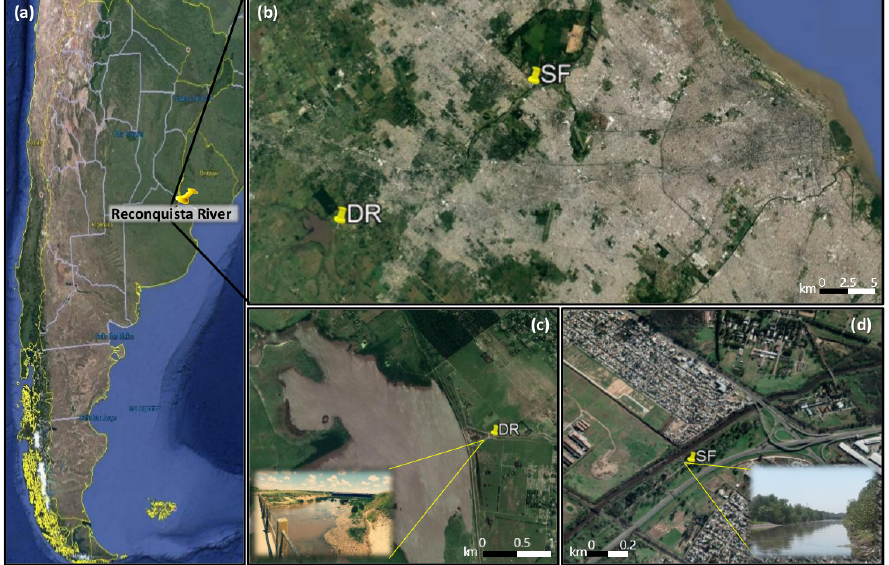
Figure 1. Satellite images of the peri urban Reconquista River location ( a ) and the two sampling sites ( b ): DR, Dique Ingeniero Carlos F. Roggero (34 ◦ 40 (cid:48) 51.4” S, 58 ◦ 51 (cid:48) 36.7” O) and SF, Parque San Francisco, William Morris, (34 ◦ 34 (cid:48) 42.3 (cid:48)(cid:48) S, 58 ◦ 40 (cid:48) 12.8 (cid:48)(cid:48) W) Buenos Aires, Argentina. Enlarged satellite images for each site: DR is located in the surroundings of a protected natural area ( c ), whereas SF is located in a densely populated area ( d ). North is at the top in all